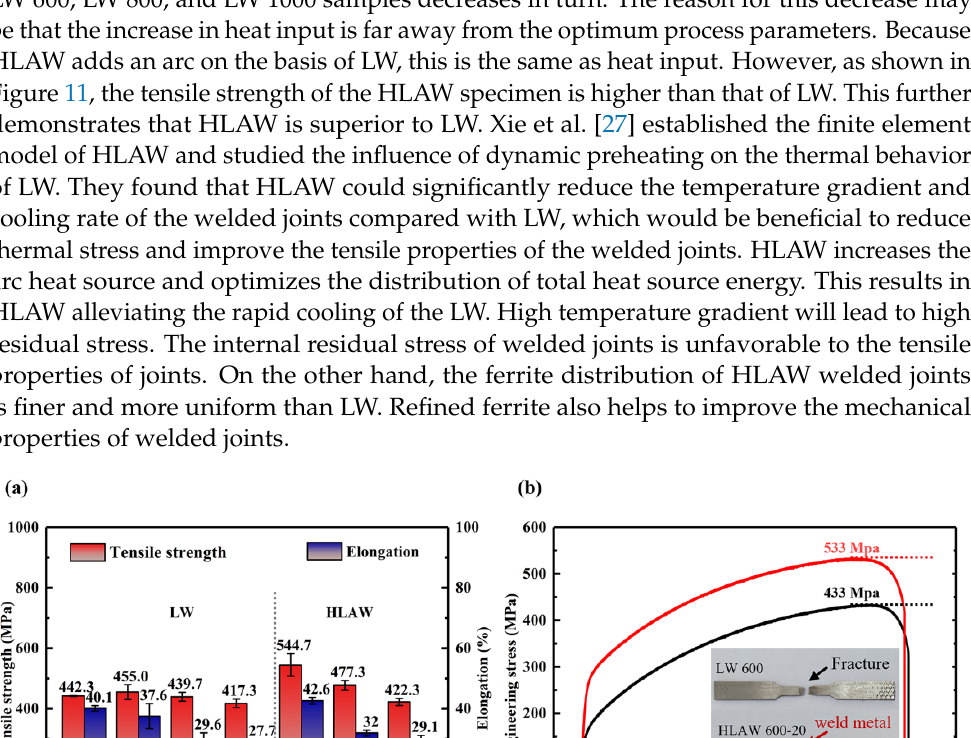
Figure 12. SEM of the fracture of the case: ( a , b ) LW 600 and HLAW 600-20, respectively; ( c , d ) higher magnification micrographs obtained from the Central areas in ( a , b ), respectively.